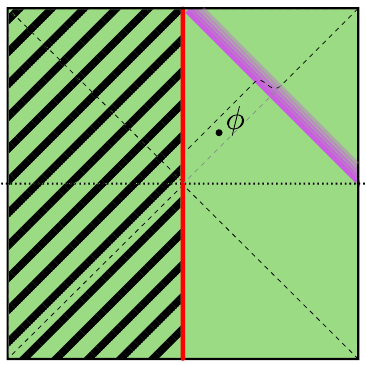
Figure 10 . The modified black hole spacetime due the deformation. The operator φ is causally con- nected to the boundary of AdS. The greyed out dotted line is the location of the undeformed